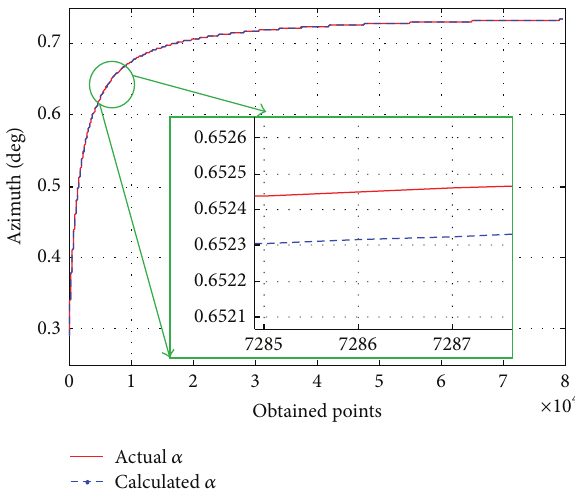
Figure 7: The variation of both the actual azimuth, 𝛼 , which is obtained geometrically, and the calculated 𝛼 , which is determined using time delays.